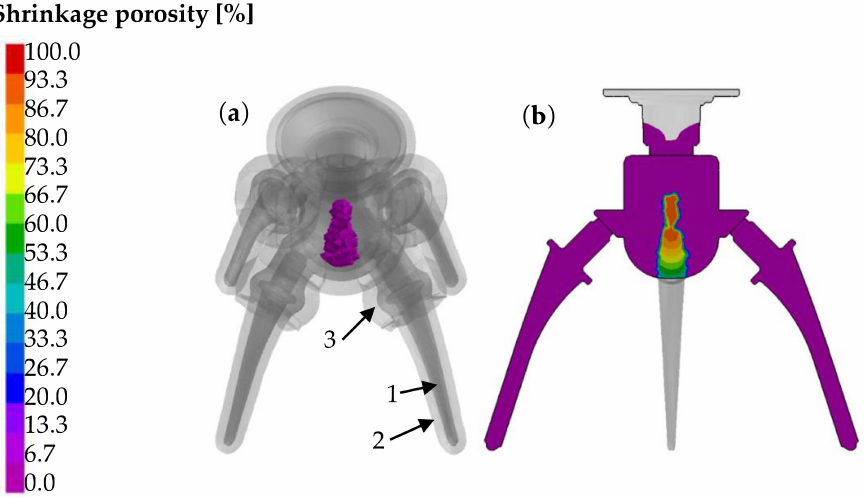
Figure 23. Hip prostheses shrinkage porosity prediction with PROCAST ® software. ( a ) Isometric view and ( b ) cross section view in plane XY. ( 1 ) Hip prosthesis, ( 2 ) ceramic shell, and ( 3 ) wool